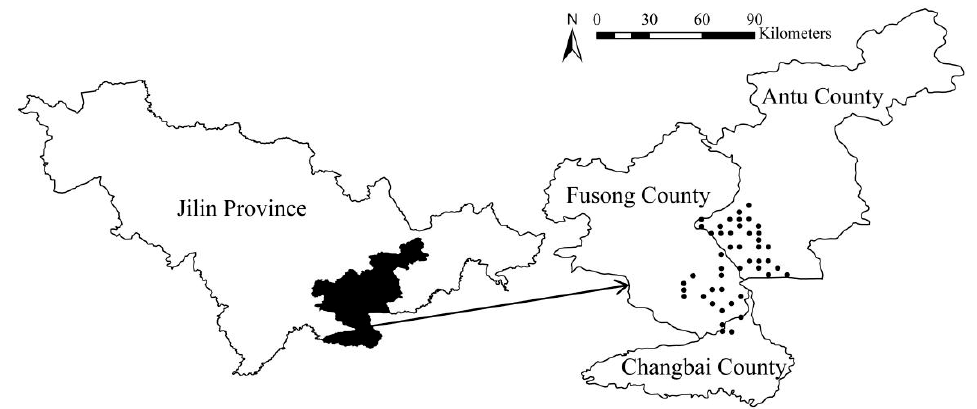
Figure 1. Study area and distribution of plots in this study.